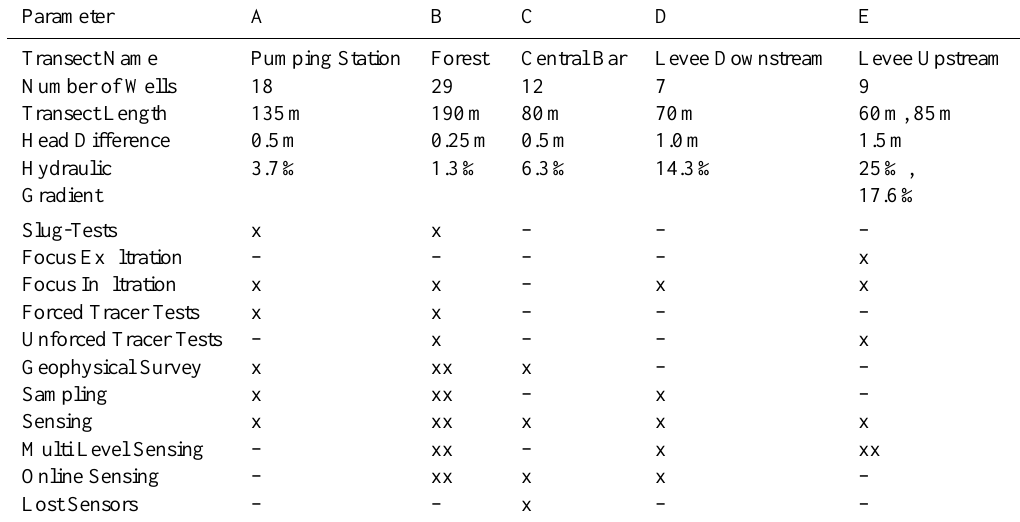
Table 3. Comparison of the five monitoring-well transects A, B, C, D and E at the test site Neunforn (x=done, xx=intensively done with focus, –= not done at that transect). The locations of the transects are illustrated in Fig. 2.